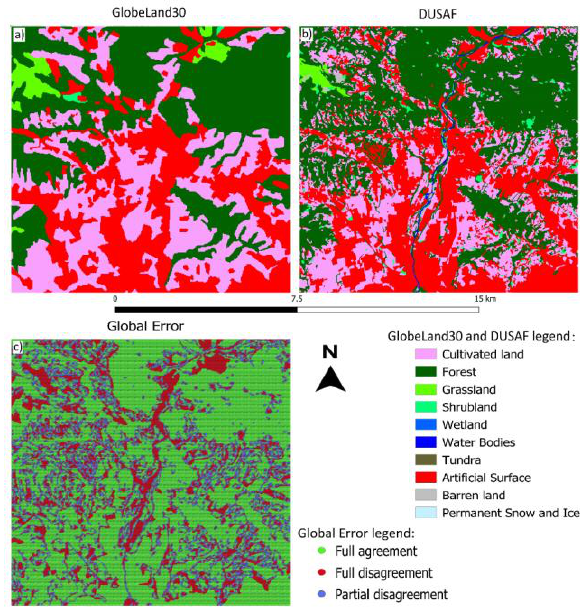
Figure 2. Portions of a) GlobLand30 and b) DUSAF raster map and c) global error map within the Lombardy Region